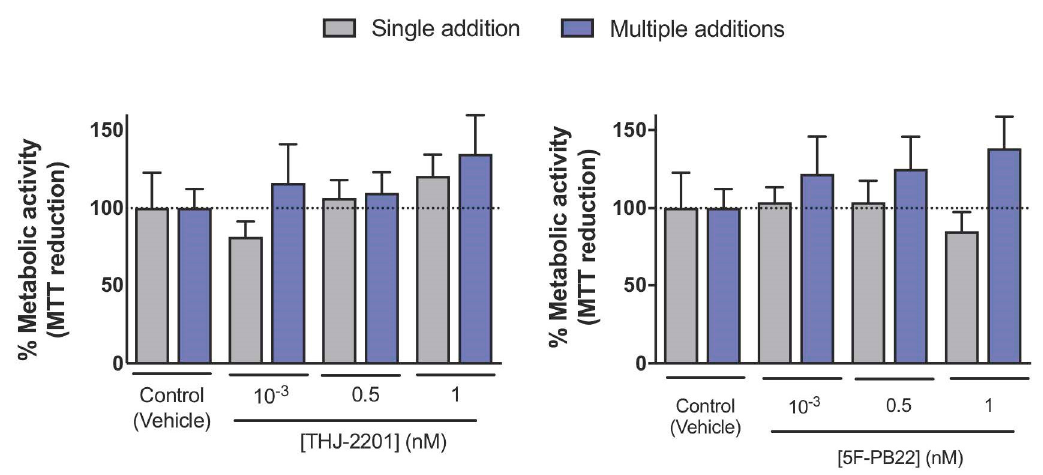
Figure 5. Metabolic activity of NG108-15 cells after the 3-day di ff erentiation period, assessed by the MTT reduction assay. Neuronal di ff erentiation was induced and NG108-15 cells were treated with 5F-PB22 or THJ-2201 as described in Materials and Methods. At the end of the di ff erentiation process (day 3), cellular metabolic activity was determined according to the MTT reduction assay, similarly to undi ff erentiated cells (also described in Materials and Methods). Bars show the mean ± S.E.M for at least four independent experiments. No statistically significant changes were observed (one-way ANOVA, followed by Dunnett’s post-test).